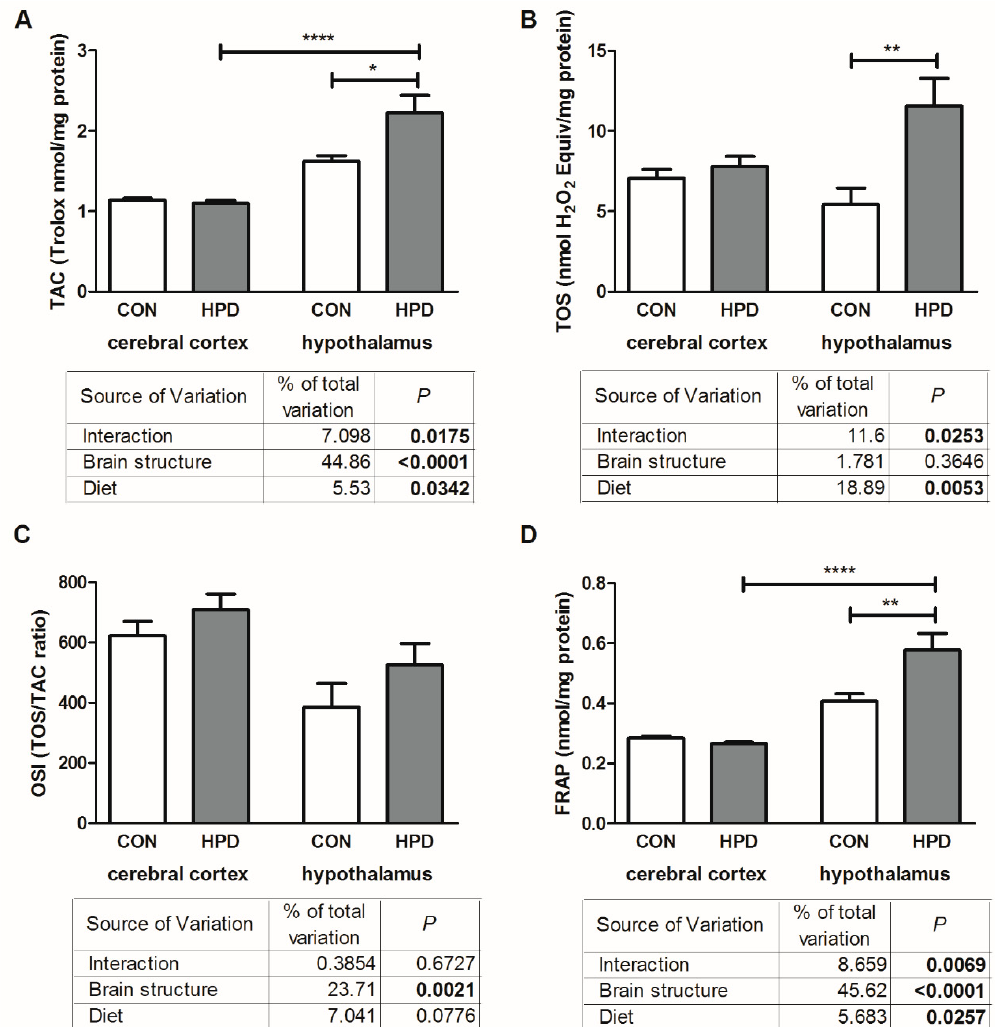
Figure 4. Effect of 8-week HPD on total antioxidant capacity ( A ), total oxidative status ( B ), oxidative stress index ( C ), and ferric reducing ability of sample ( D ), in rat cerebral cortex and hypothalamus. Values are means ± SEMs, n = 9. Differences statistically significant at: * p < 0.05, ** p < 0.005, **** p < 0.0001. CON, standard diet; FRAP, ferric reducing ability of sample; HPD, high protein diet; OSI, oxidative stress index; TAC, total antioxidant capacity; TOS, total oxidative status.